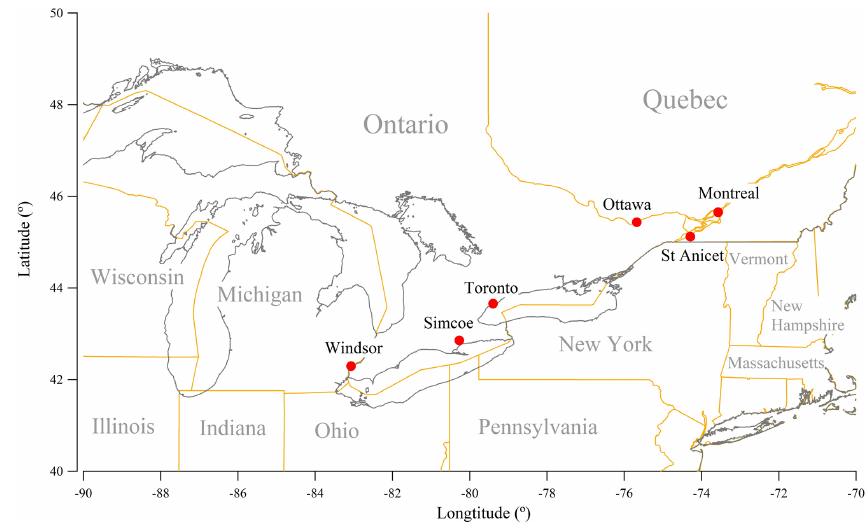
Figure 1. Six NAPS monitoring sites chosen for this study: Toronto, Ottawa, Windsor, Montreal, Simcoe and St Anicet.